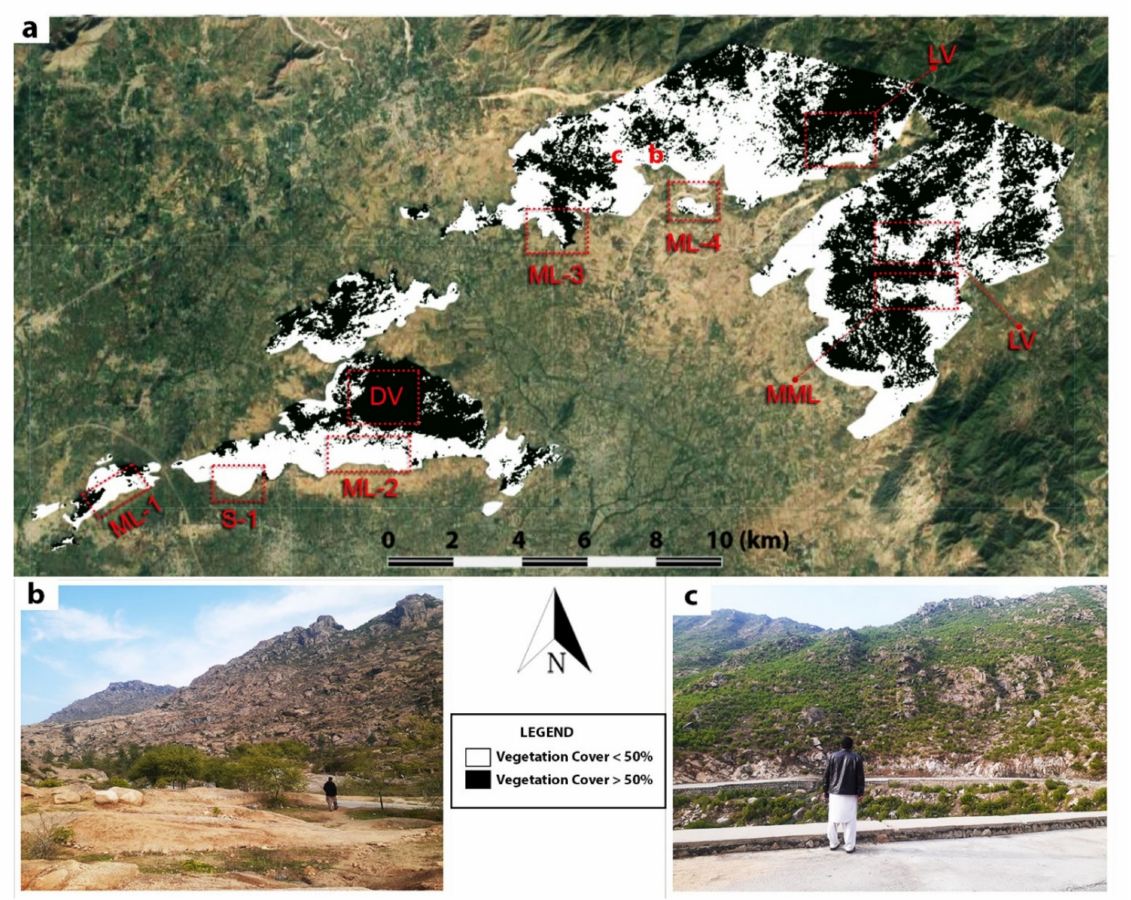
Figure 11. ( a ) Binarized normalized difference vegetation index (NDVI) of >0.50% showing pixels with higher vegetation cover in black color; ( b ) low vegetation region (72 ◦ 21 (cid:48) 48 (cid:48)(cid:48) E, 34 ◦ 19 (cid:48) 44 (cid:48)(cid:48) N); ( c ) medium vegetation region (72 ◦ 21 (cid:48) 8 (cid:48)(cid:48) E, 34 ◦ 20 (cid:48) 13 (cid:48)(cid:48)